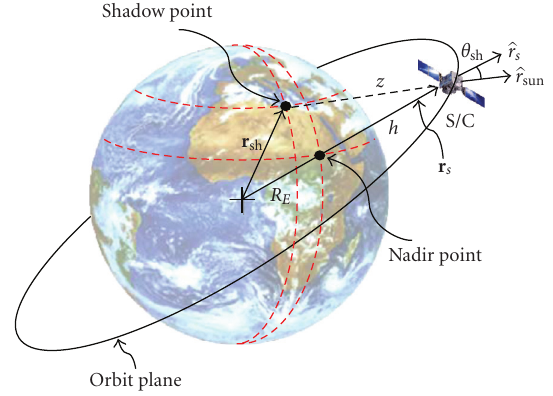
Figure 2: Shadow position vector, r sh , and shadow angle θ sh